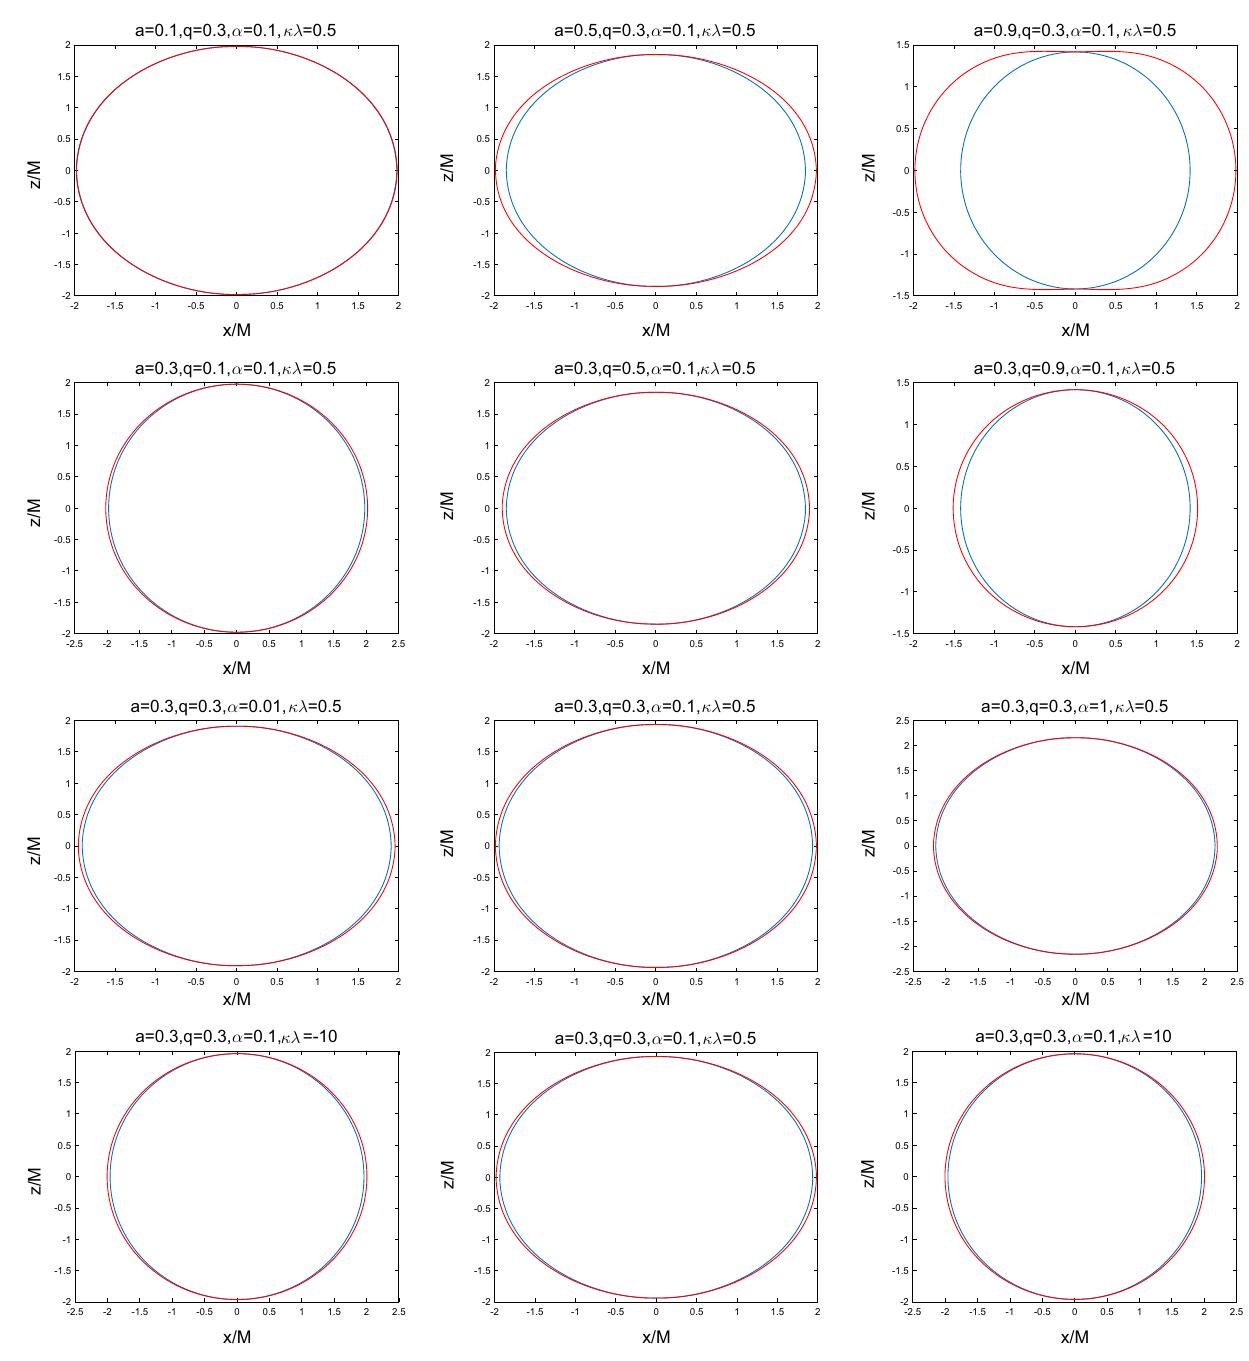
Fig. 1 The ergosphere areas of the KN-AdS black hole surrounded by dark energy ( ω = − 2 / 3) in the Rastall gravity for different a , Q ,α,κλ . The ergosphere region is between the event horizon (blue line) and the stationary limit surface (red line). The cosmological constant is set as (cid:15) (cid:9)